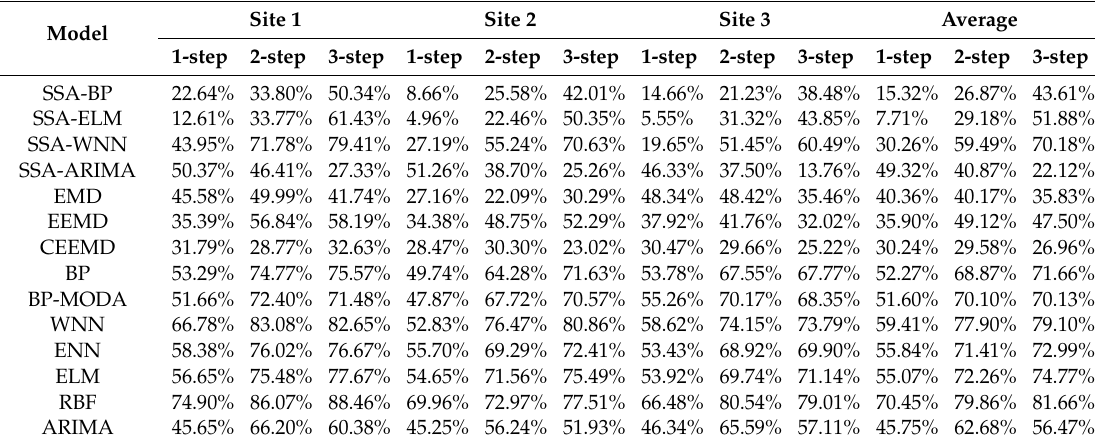
Table 10. Percentage improvement of the proposed